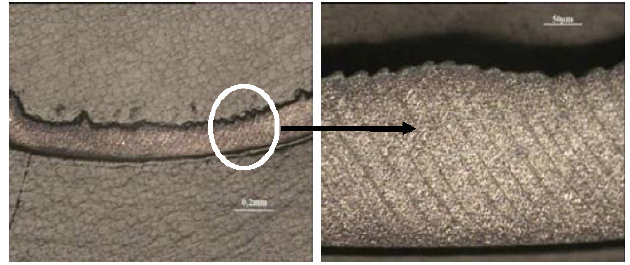
Figure 13. Chip morphology of Ti-55531 (35 m/min, tool